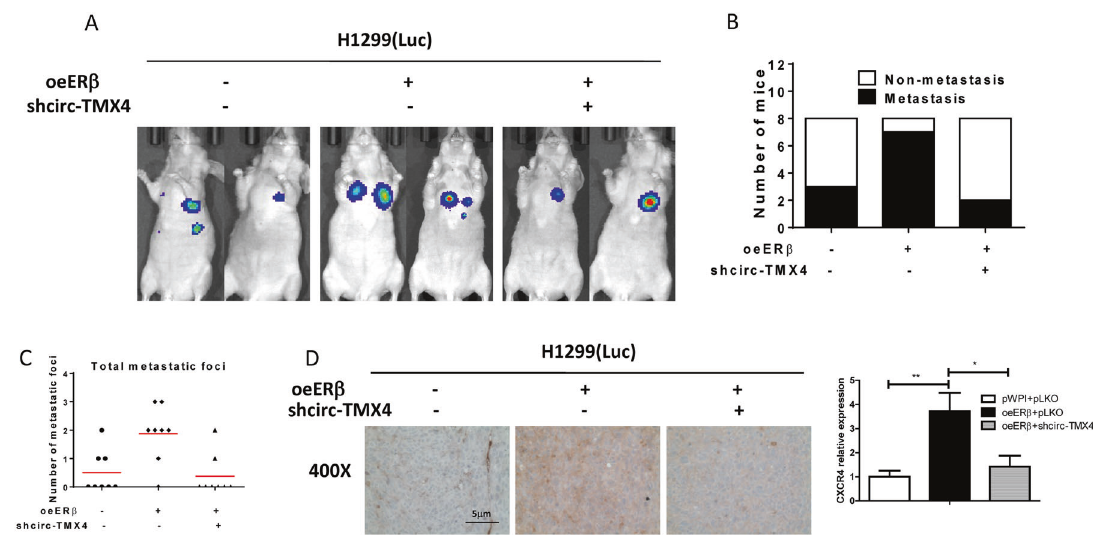
Fig. 6 Preclinical study using the in vivo mouse model to demonstrate the role of ER β /circ-TMX4/miR − 622/CXCR4 signaling in the lung cancer progression. A IVIS imaging was used to detect the various distal metastasis foci in mice. B Quanti fi cation of the mice with metastasis. C Quanti fi cation of the total metastatic foci. D IHC assay was used to check CXCR4 expression in mice tumor tissues in each group. All quantitations are presented as mean ± SD and p values calculated by t -test, * p < 0.05, ** p <